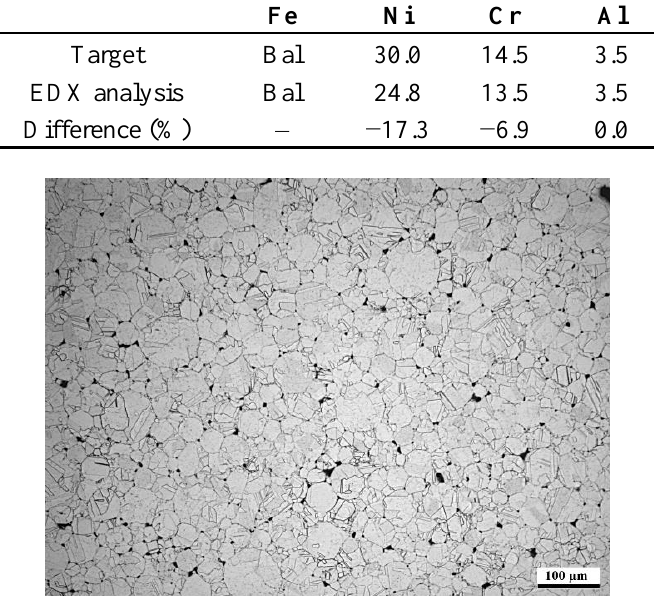
Figure 6. Microstructure of the HIP’ed FeNiCrAl alloy before